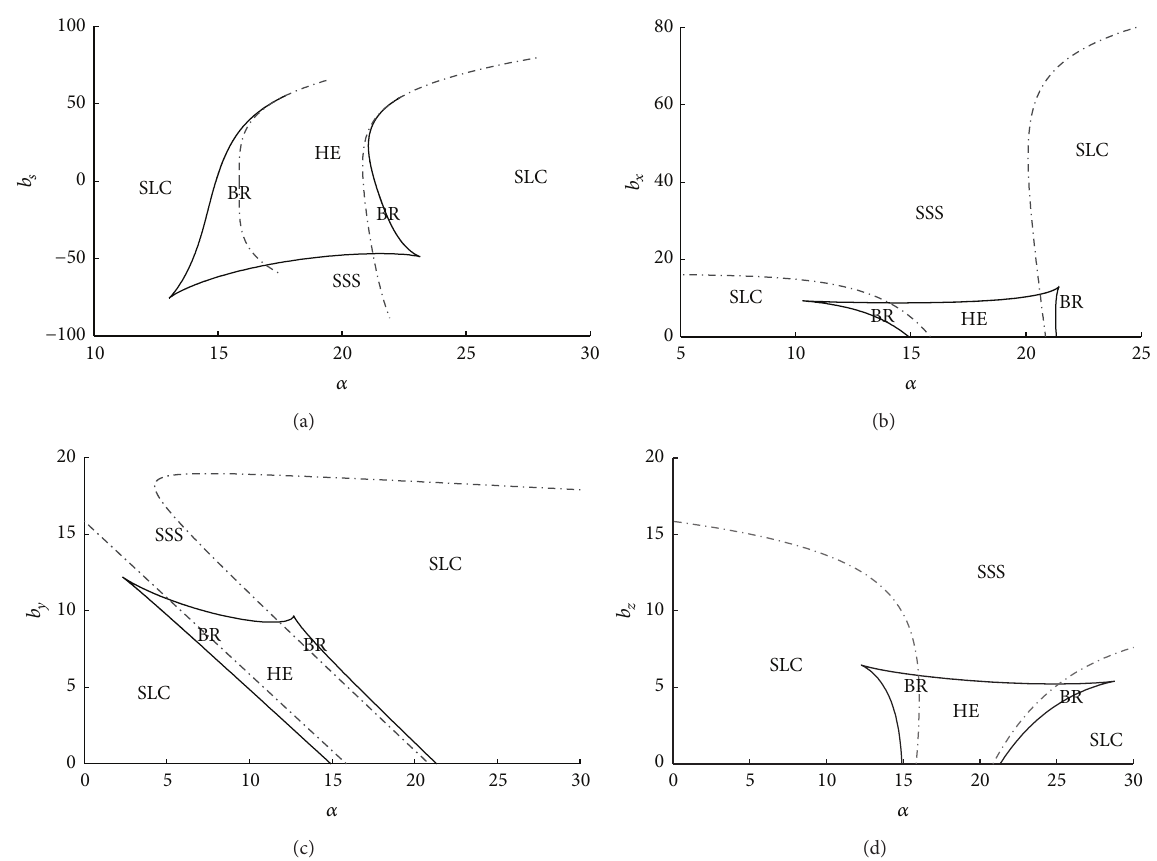
Figure 5: Bifurcation diagram of parameter 𝛼 versus parameters 𝑏 𝑠 , 𝑏 𝑥 , 𝑏 𝑦 , and 𝑏 𝑧 for model (1).